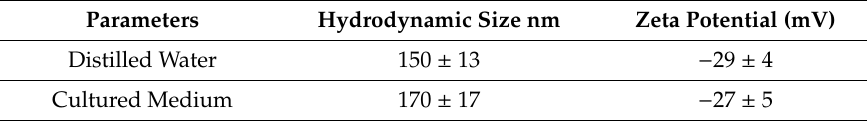
Table 1. Dynamic light scattering (DLS) characterization of SWCNTs (mean ± SD, n = 3).